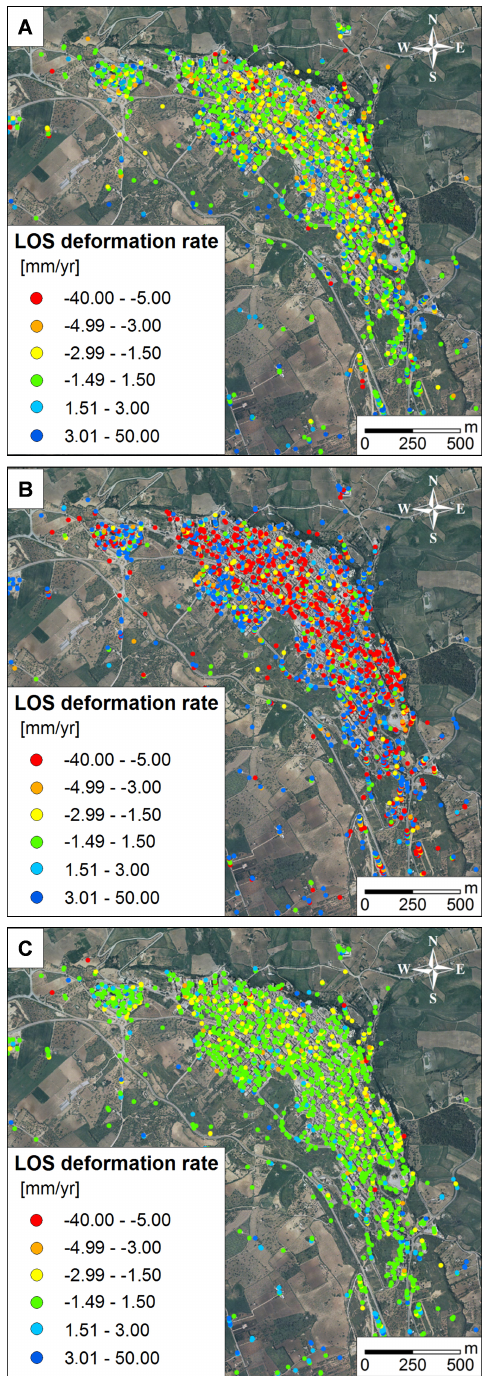
Fig. 9. Sub-sampling of Naro deformation time series into three different intervals: (A) (March 2003–September 2004), variable deformation rates; (B) (September 2004–March 2005), acceleration; (C) (March 2005–May 2007), stabilization. PS deformation rates are measured along the LOS of RADARSAT-1 satellite in ascending mode (see also Fig. 5b). Negative deformation values indicate movement toward the satellite; positive values indicate movement away from the